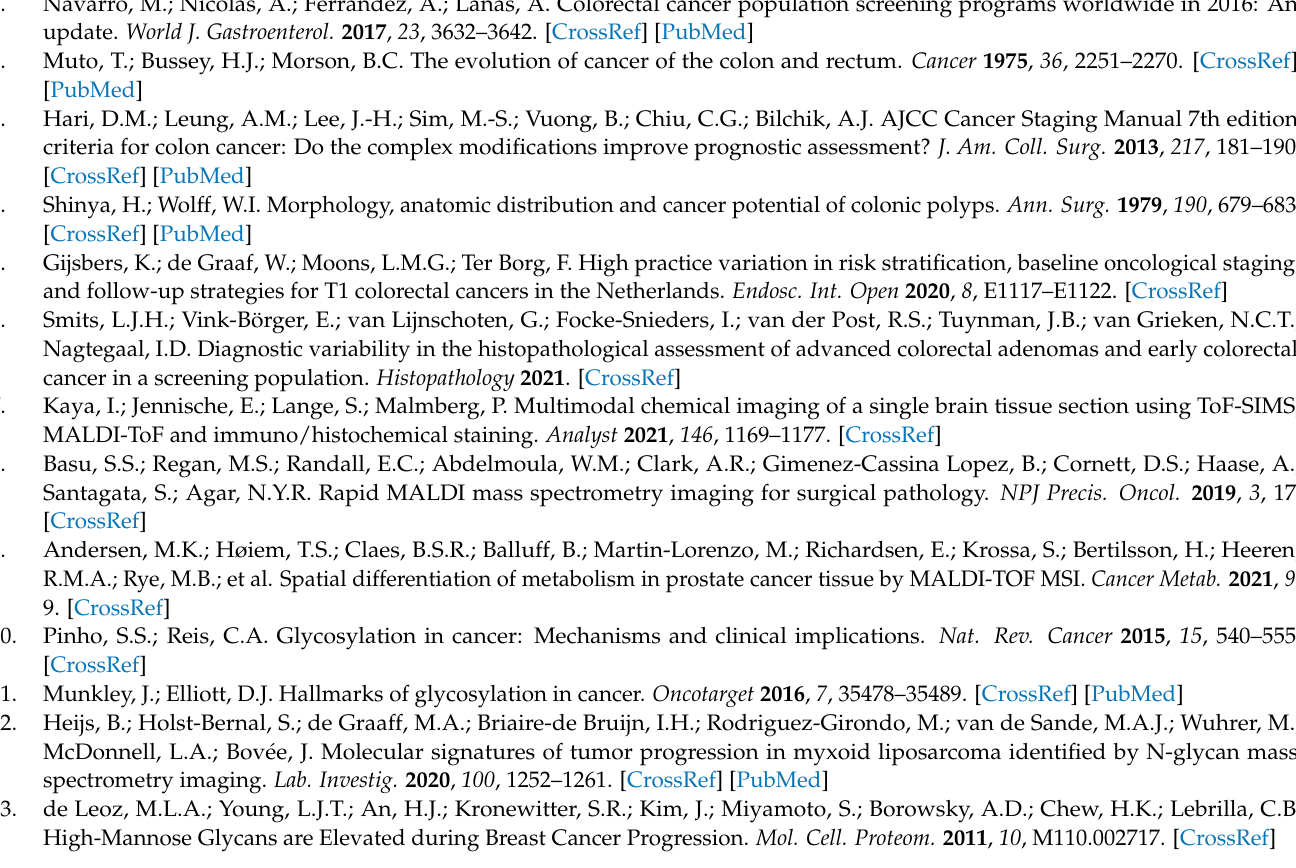
Table S3: Overview of the 58 N -glycans detected by MALDI-MSI; File S1: Histological annotation of the